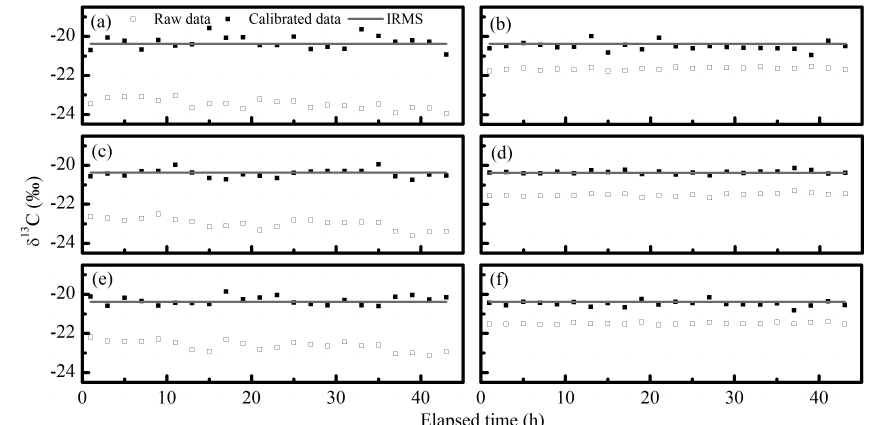
Figure 4. Time variations of δ 13 C of the three different CO 2 concentrations with same δ 13 C reference gases (Ref1, Ref2 and Ref3) of G1101-i before upgradation (G1101-i-original) (a, c, e) and G2201-i (b, d, f) analyzers. Panels (a) and (b) show data from Ref1, panels (c) and (d) show data from Ref2, and panels (e) and (f) show data from Ref3.